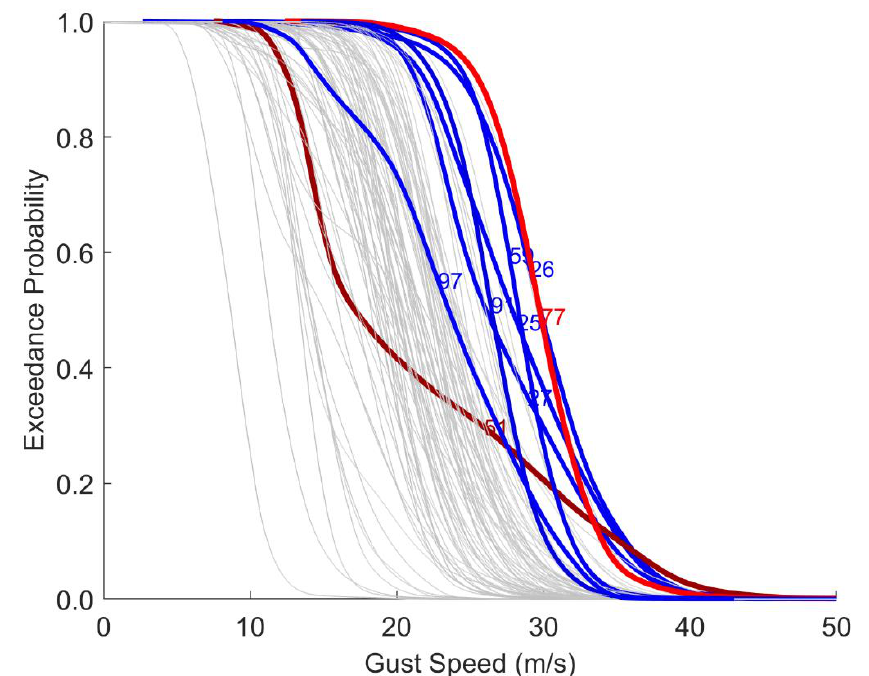
Figure 8. Survival functions (SF) of the winter storm related gust speed ( GS ) representing the share of study area. The eight most severe winter storms are labeled with their ID. The two winter storms (ID: 77, Kyrill; ID: 51: Lothar) which caused the greatest losses are colored red. The six next severe winter storms are colored blue. The grey lines indicate all other winter storms.